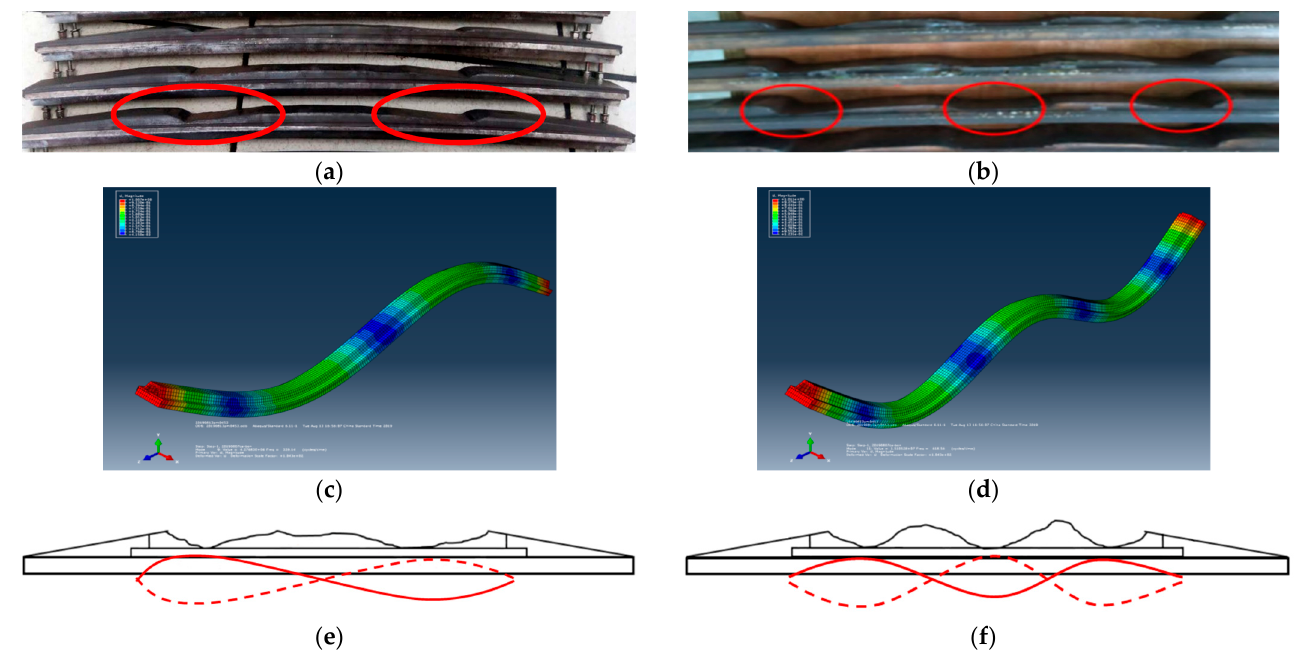
Figure 15. Relationship between the wear pattern and the dominant mode shapes of the pantograph strip. ( a ) Irregular wear with two grooves. ( b ) Irregular wear with three grooves. ( c ) Mode shape of the 2nd vertical mode. ( d ) Mode shape of the 3rd vertical mode. ( e ) Two-grooves wear pattern vs. mode shape of the 2nd vertical mode. ( f ) Three-groove wear pattern vs. mode shape of the 3rd vertical mode.